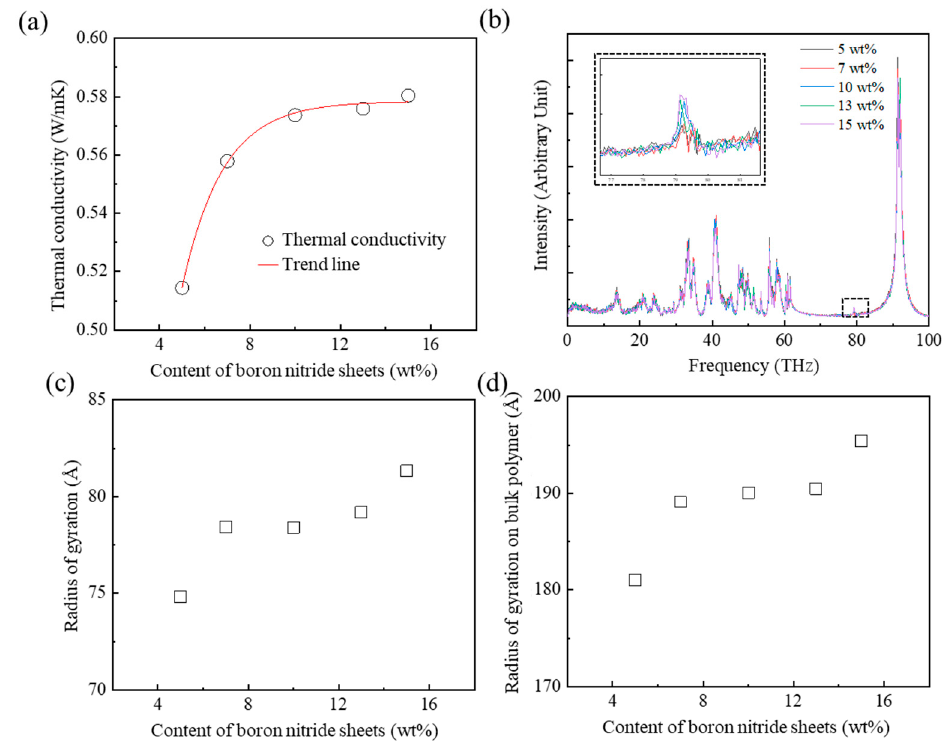
Figure 6. Thermal transport according to the content of boron nitride sheets in PEEK/BN composites: ( a ) thermal conductivities, ( b ) PDOS of composites, ( c ) radius of gyration, and ( d ) radius of gyration on the bulk polymer.